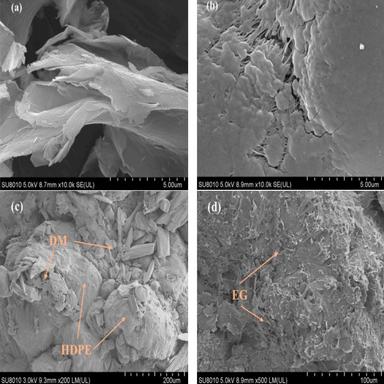
The SEM morphology of (a) EG, (b) HDPE, (c) PCM3, (d) CPCM1.